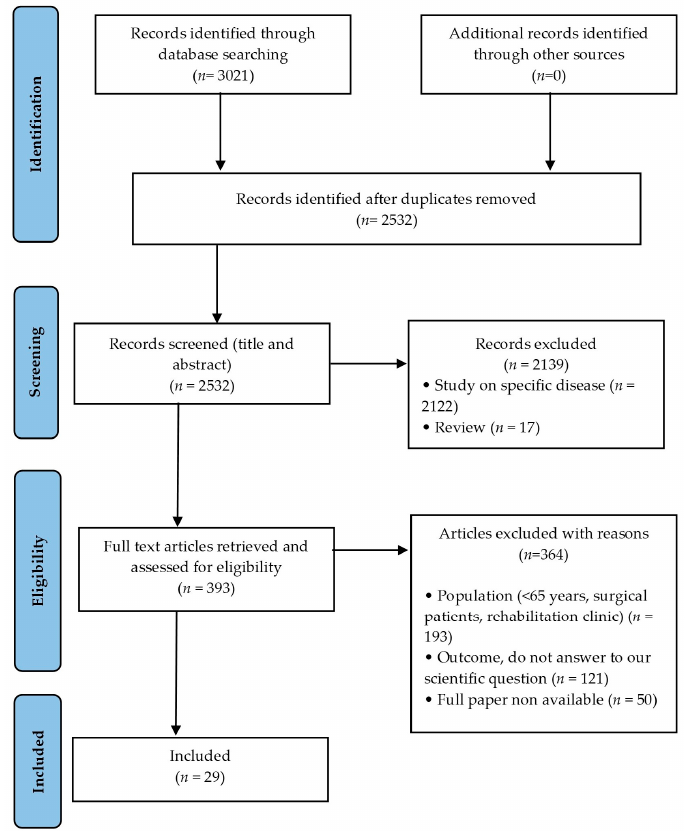
Figure 1. Flowchart of the study selection process.